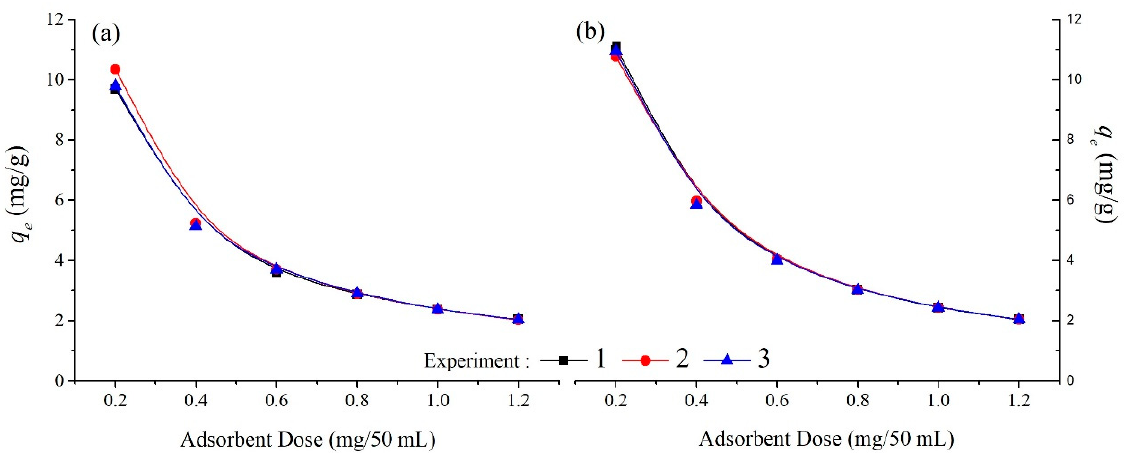
Figure 8. Effect of adsorbent dosage on adsorption capacity of ( a ) Basic Navy Blue 2RN and ( b ) Drimaren Yellow CL-2R. Adsorbate concentration 50 mg/L. pH (cationic) = 6, pH (anionic) = 2.